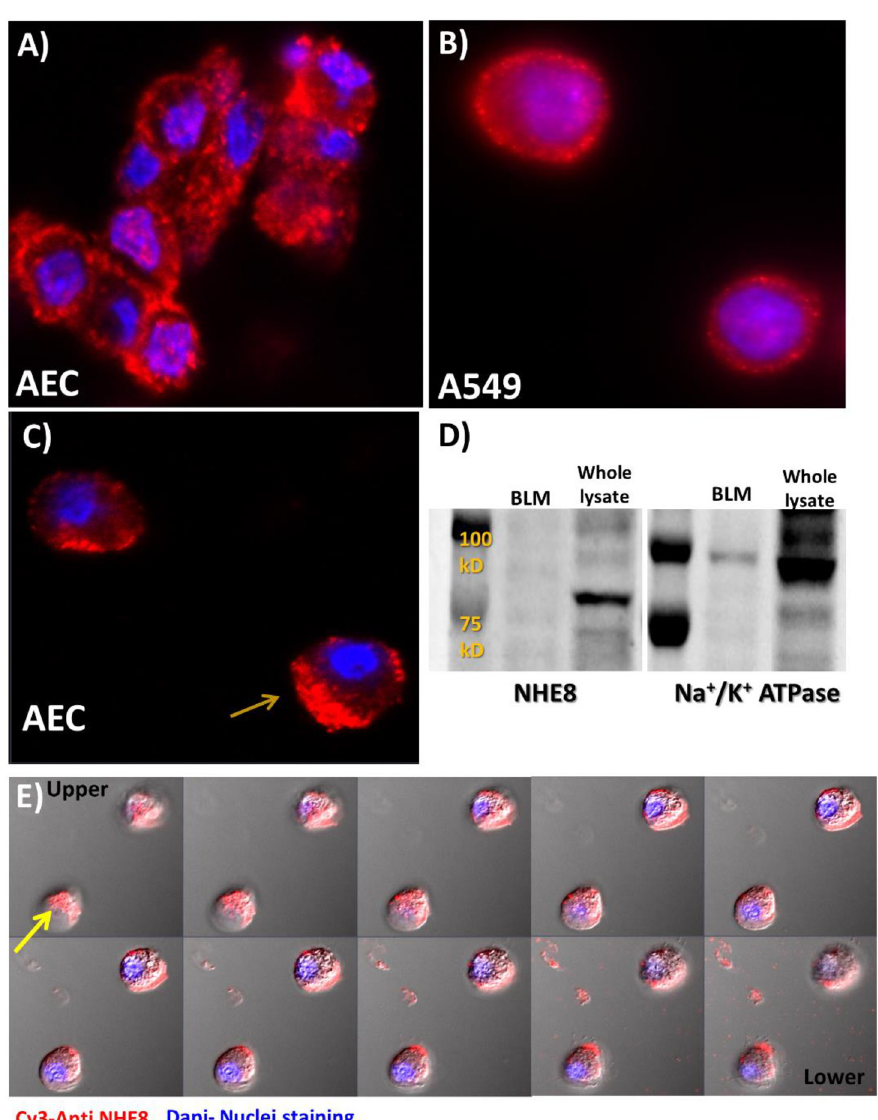
Fig 2. Immunofluorescence staining of NHE8 stained with Cy3 (Red) in isolated AEC (A and C) and A549 cell line (B), showing strong staining at the plasma membrane and a polar distribution in part of the cells (C). Nuclei were stained with Dapi (blue). (D) Western blot to BLM and whole lung lysate showing no existence of NHE8 in BLM fraction; yet, Na + /K + ATPase used as a marker of basolateral membranes do exist. (E) NHE8 localization to apical membrane of alveolar epithelial cells was achieved by series of images taken by confocal microscope. The first image refers to the apical side while the last one refers to the basolateral side. The red signal got weaker as we imaged deeper; more obvious in the cell pointed with yellow arrow. BLM—basolateral membranes. NHE—Na+/H+ Exchanger.